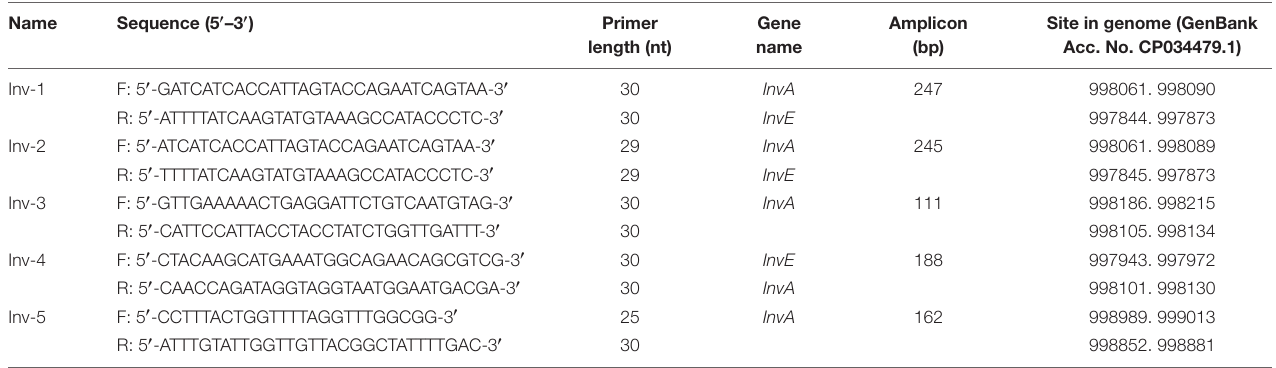
TABLE 1 | Primer sequences and targeting areas.